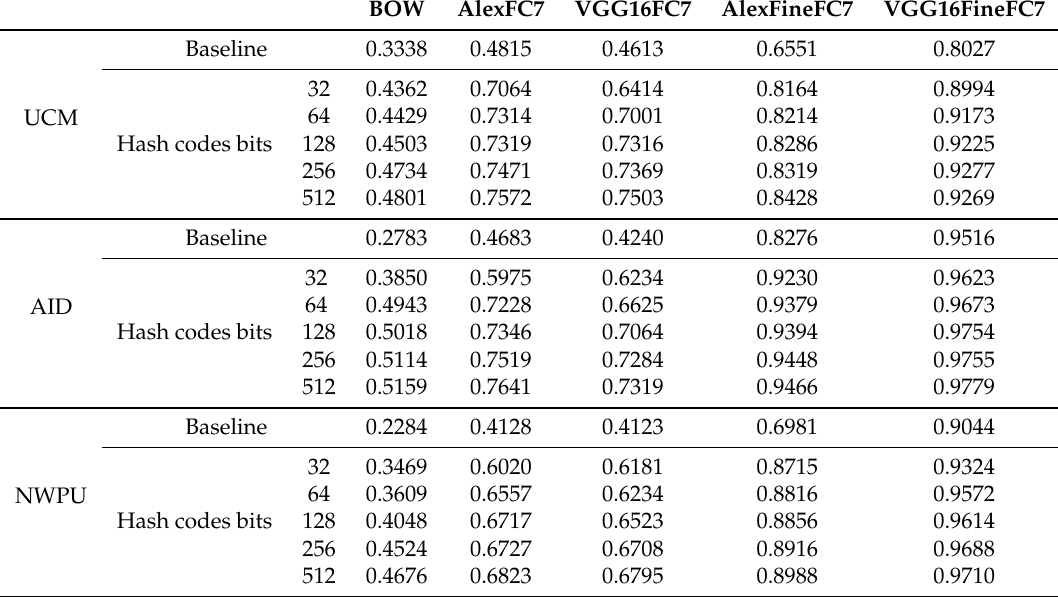
Table 6. Retrieval mean average precision counted on three archives based on different visual features using Top 50 retrieval